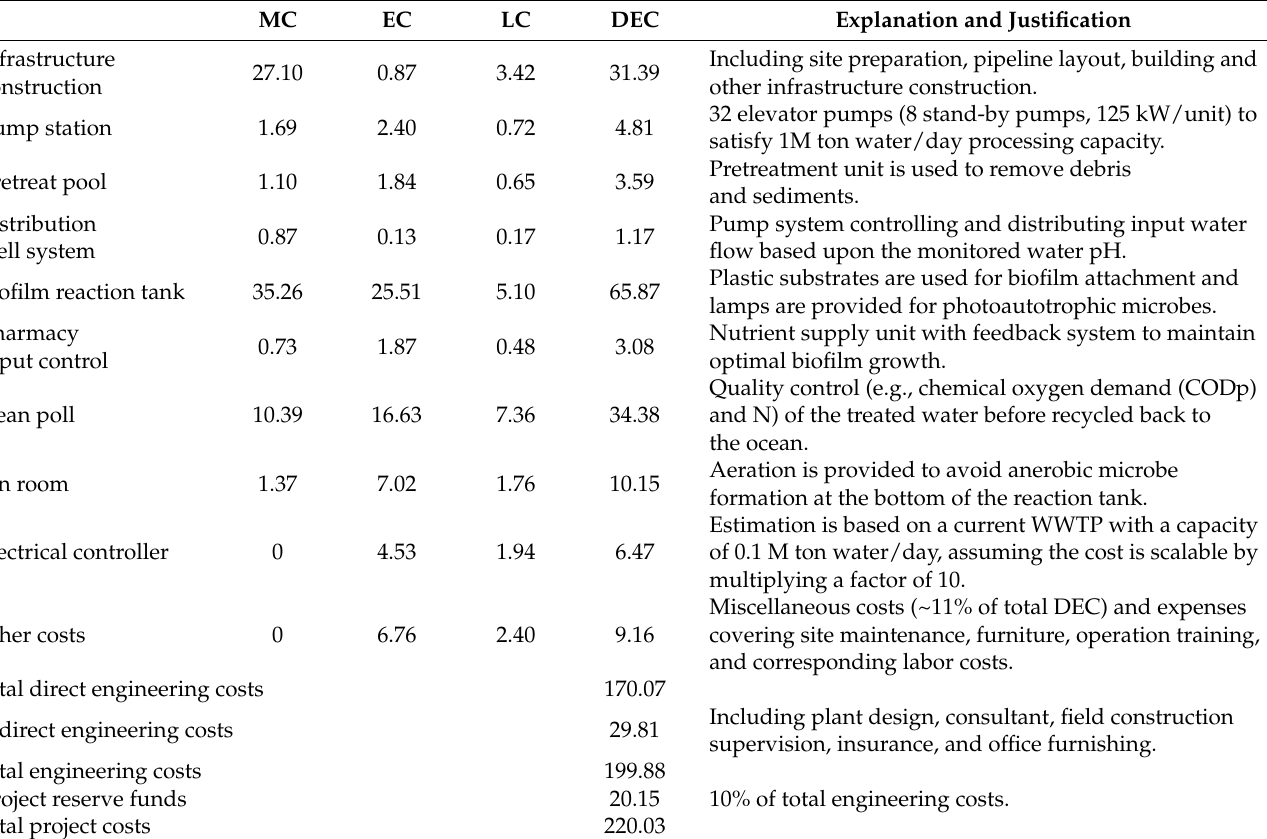
Table 1. Fix asset investment ($million) for a 10 6 tCO 2 /year MI-DAC